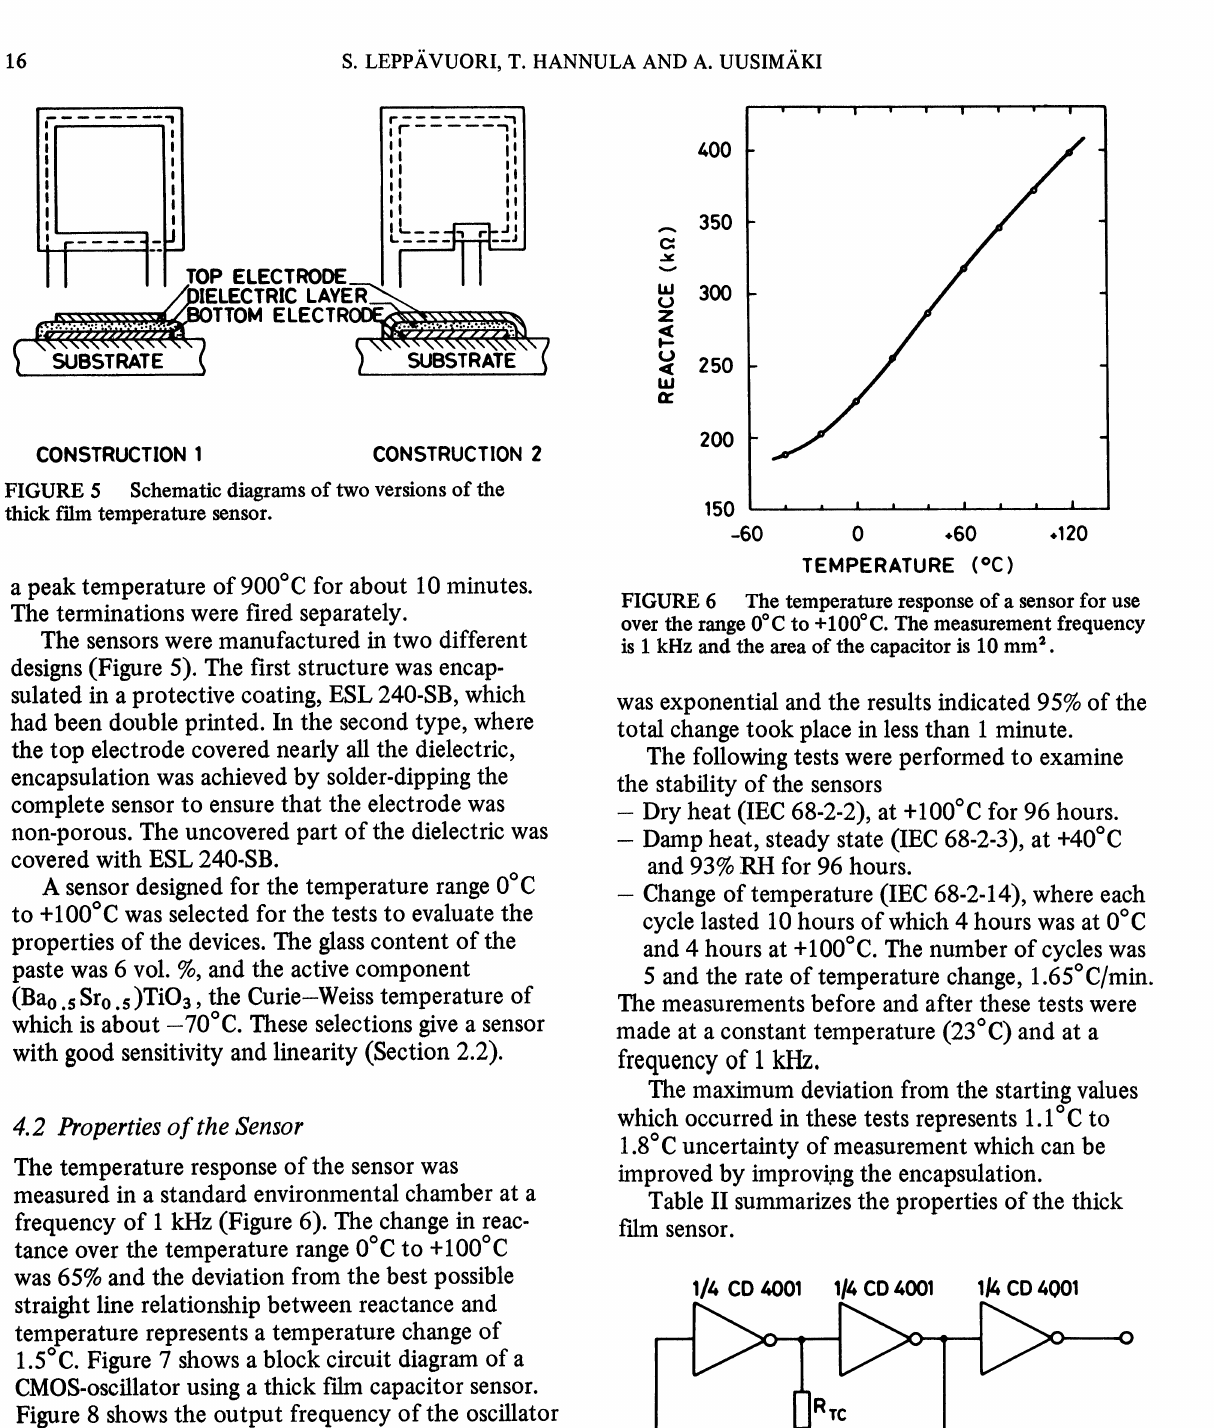
The block diagram of a CMOS-oscillator using a thick film capacitive sensor